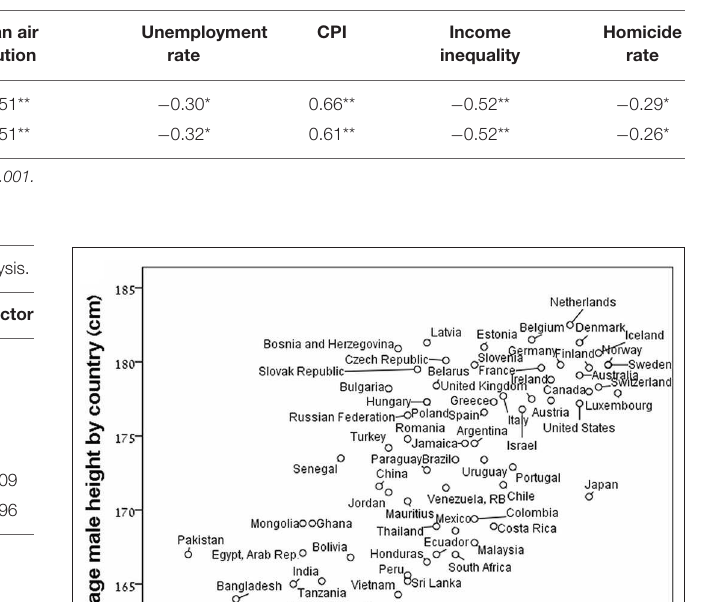
TABLE 1 | The Pearson’s correlation coefficients between the seven indicators of environmental stress and male and female heights.